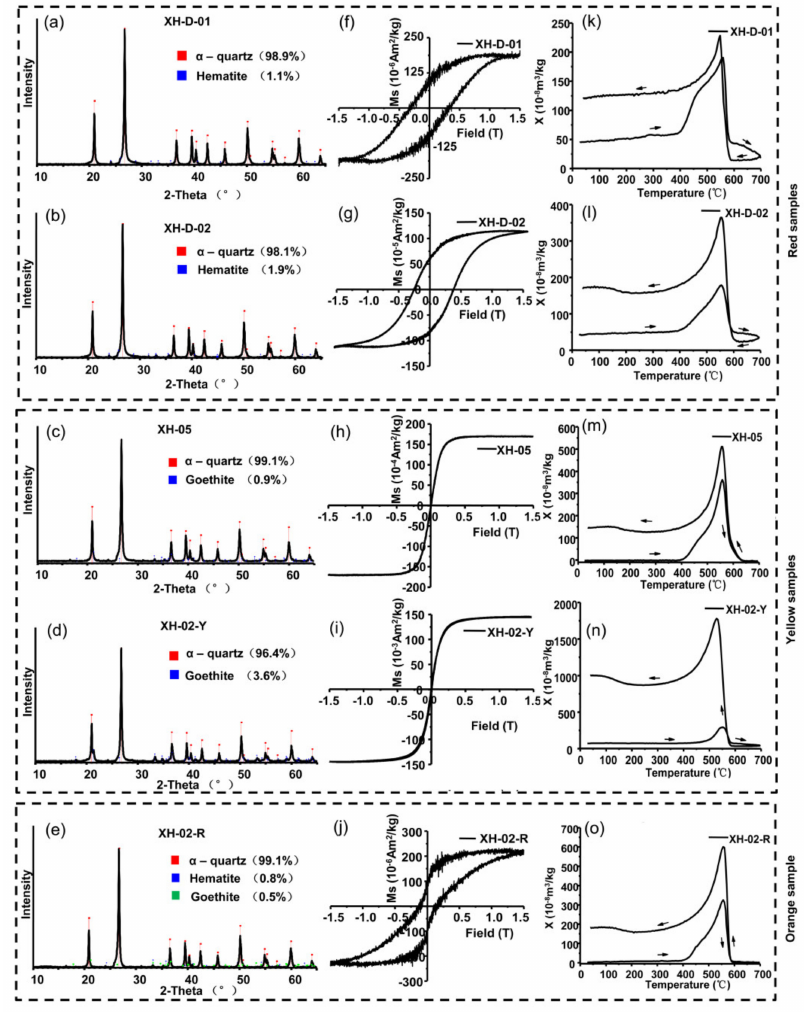
Figure 4. XRD patterns ( a – e ), hysteresis loops ( f – j ) and temperature-dependent susceptibility curves ( χ -T curves, k – o ) of investigated